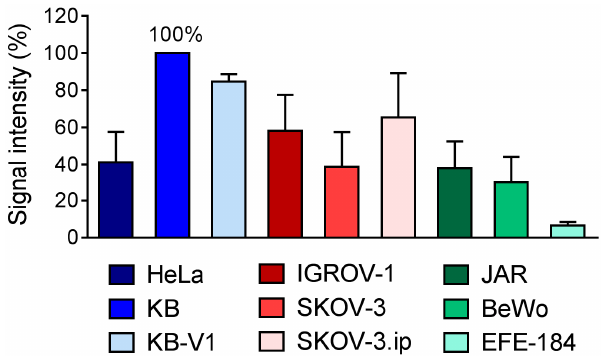
Figure 2. Quantification of signal intensity obtained from western blot for FR-expression in cervical, ovarian, choriocarcinoma and endometrial cancer cell lines. The value obtained for KB cells was set as 100% and the percentage of the signals of the other cell lines was calculated for each single western blot ( n = 5–6) and expressed as the average ± standard deviation.